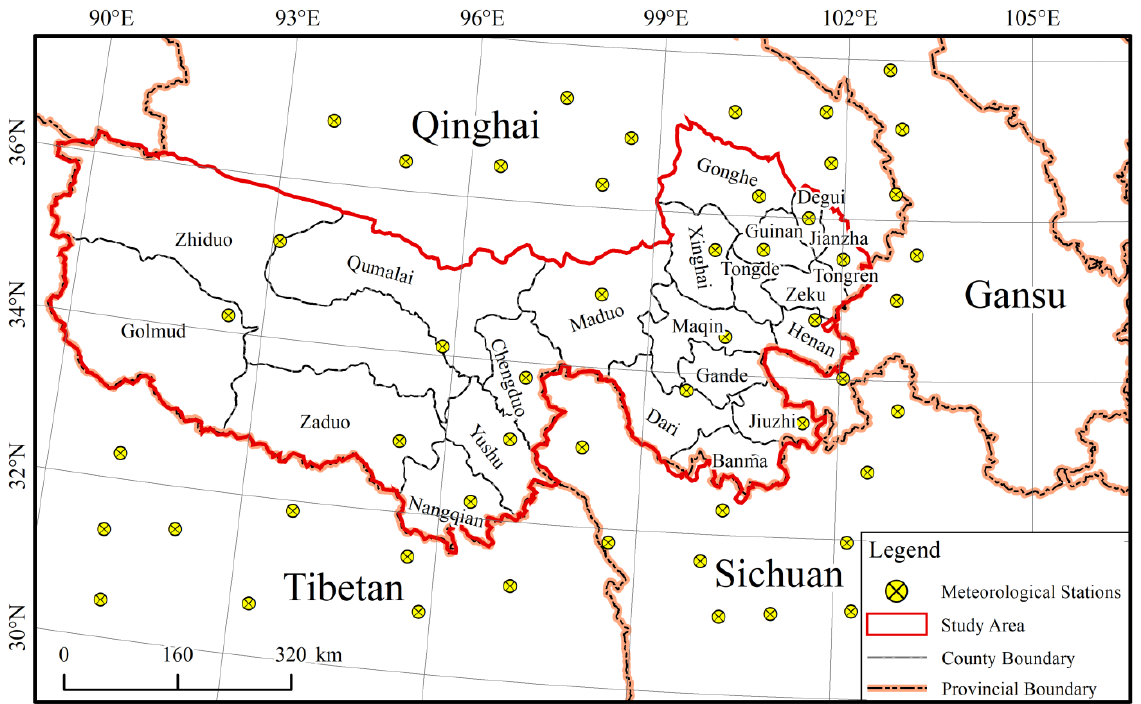
Figure 2. Distribution of the meteorological stations.